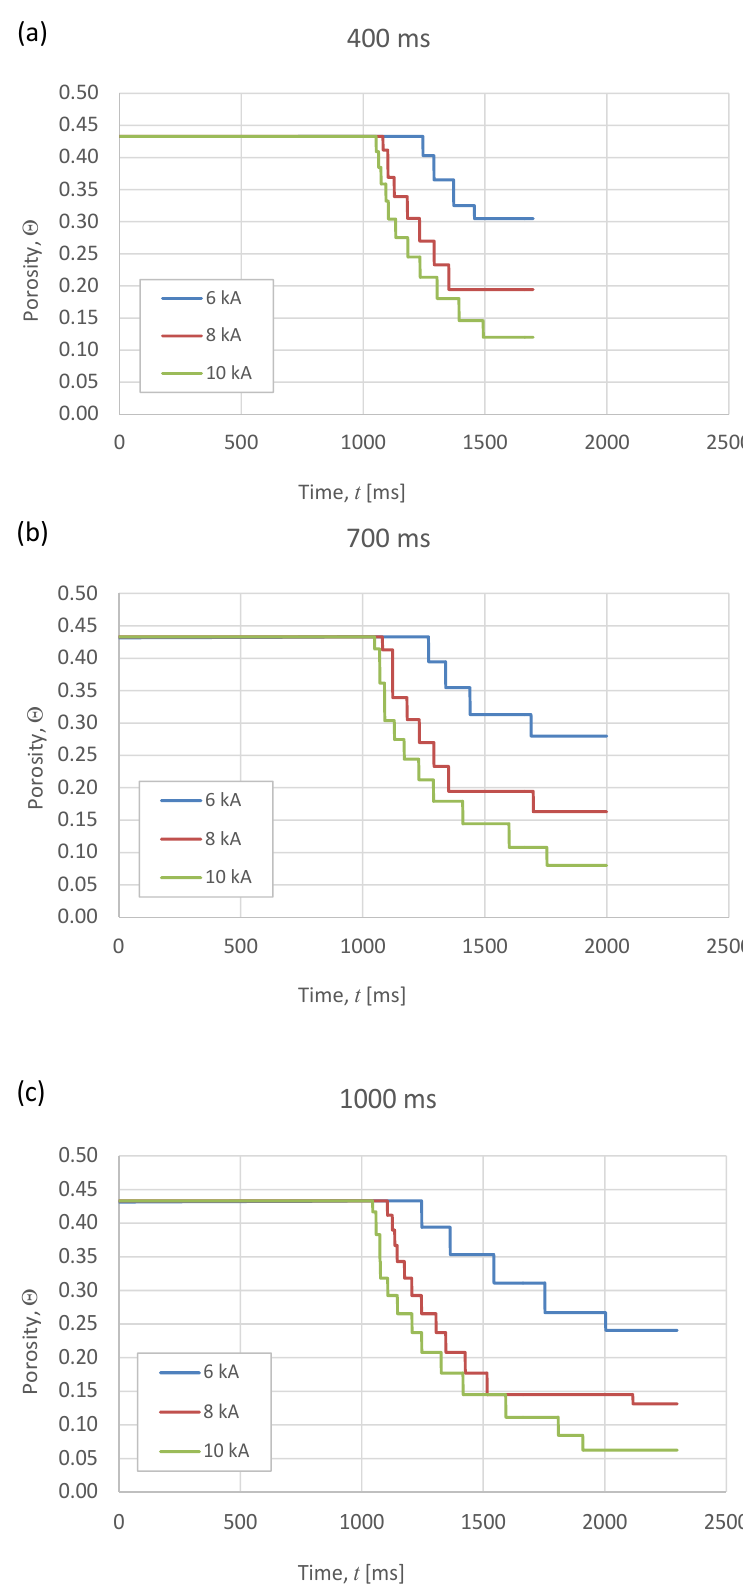
Figure 6. Evolution of the global porosity Θ , as a function of the current intensity, for different heating times: ( a ) 400 ms, ( b ) 700 ms, and ( c ) 1000 ms. The intensity starts passing through the specimen after 1000 ms and stops 300 ms before the end of the process.